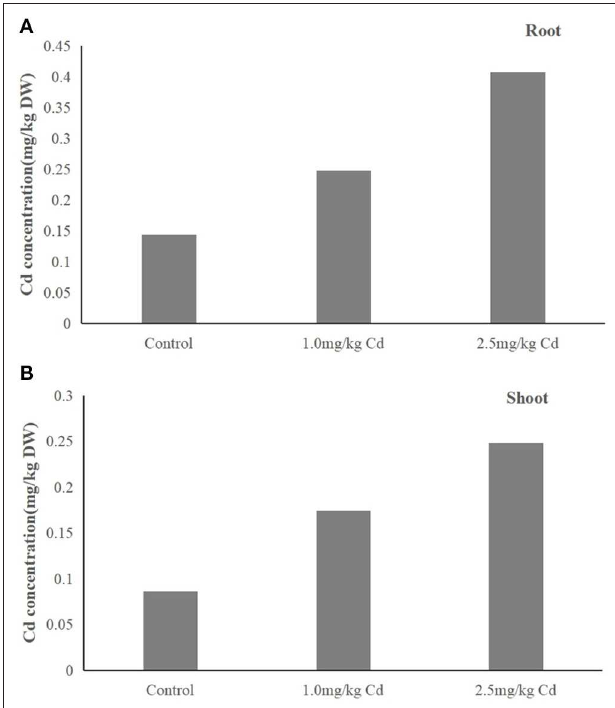
FIGURE 3 | (A,B) Distribution of Cd in the tissues of snapdragons under two Cd treatments.